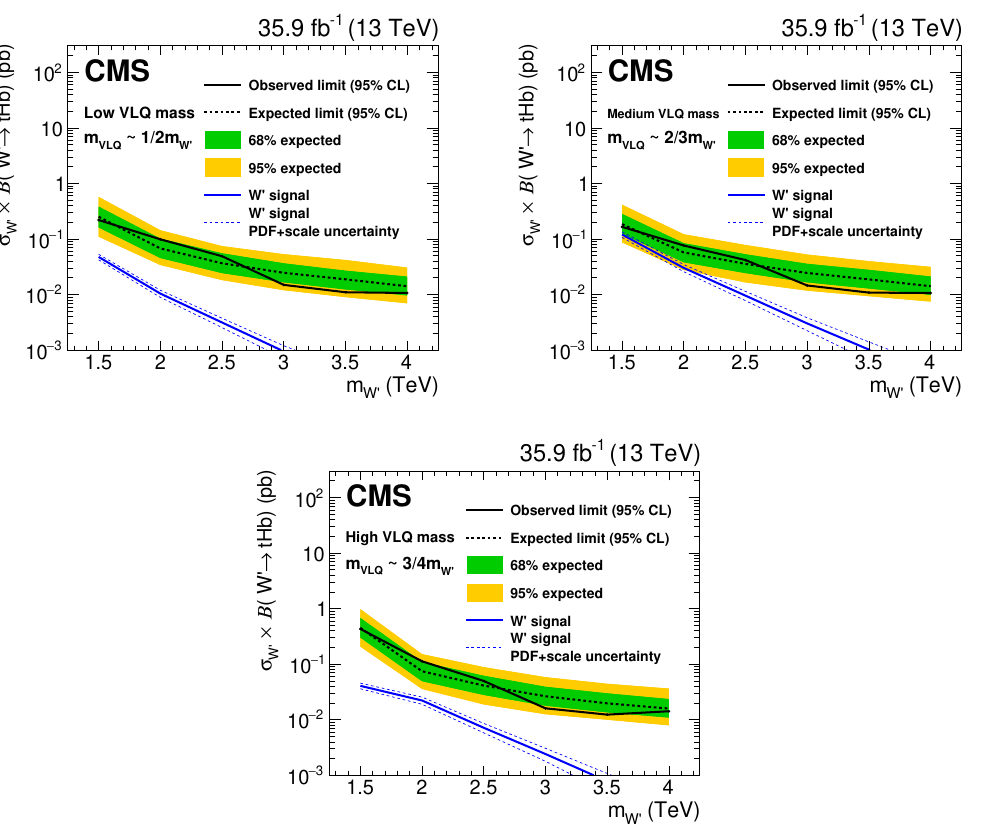
Figure 8 . The W boson 95% CL production cross section limits. The expected limits (dashed) 0 and observed limits (solid), as well as the W boson theoretical cross section and the PDF and scale 0 normalization uncertainties are shown. The bands around the expected limit represent the 2 (cid:27) exp uncertainties in the expected limit. The limits for low- (upper left), medium- (upper right), (cid:6) and high- (lower) mass VLQ mass ranges, de(cid:12)ned in table 2, are